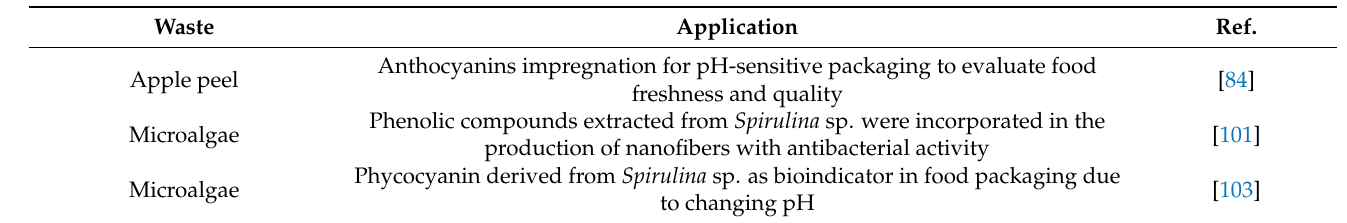
Table 11. Summary of different packaging applications of bioactive compounds and pigments from microalgae and food wastes.